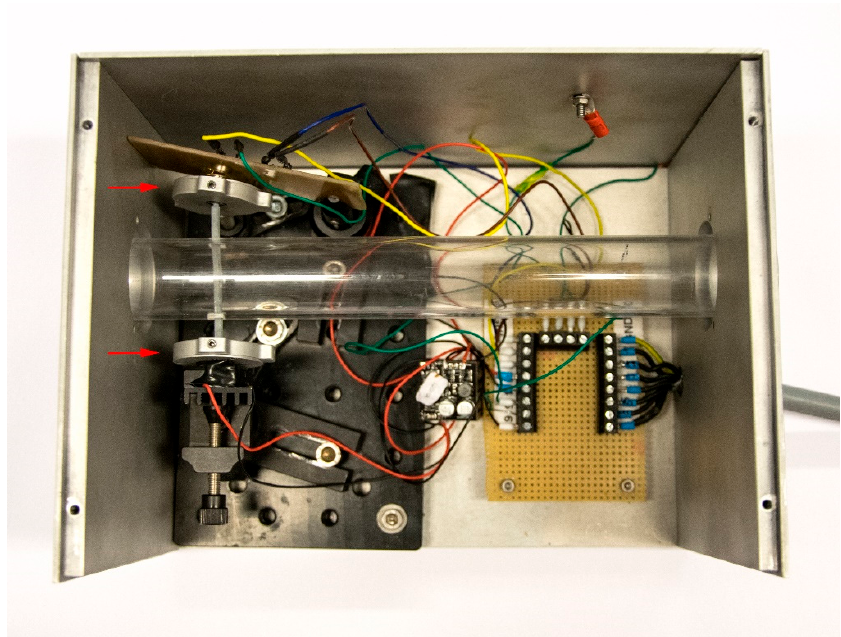
Figure 5. Setup for measurements in air flow. The fiber was integrated into a transparent flow tube (Ø 30 mm) with fiber clamps (red arrows) on each side to ensure a reproducible fixation. The setup is incorporated into an aluminum cage to shield the electronics against interferences. A ventilator on one side of the tube creates the air flow.